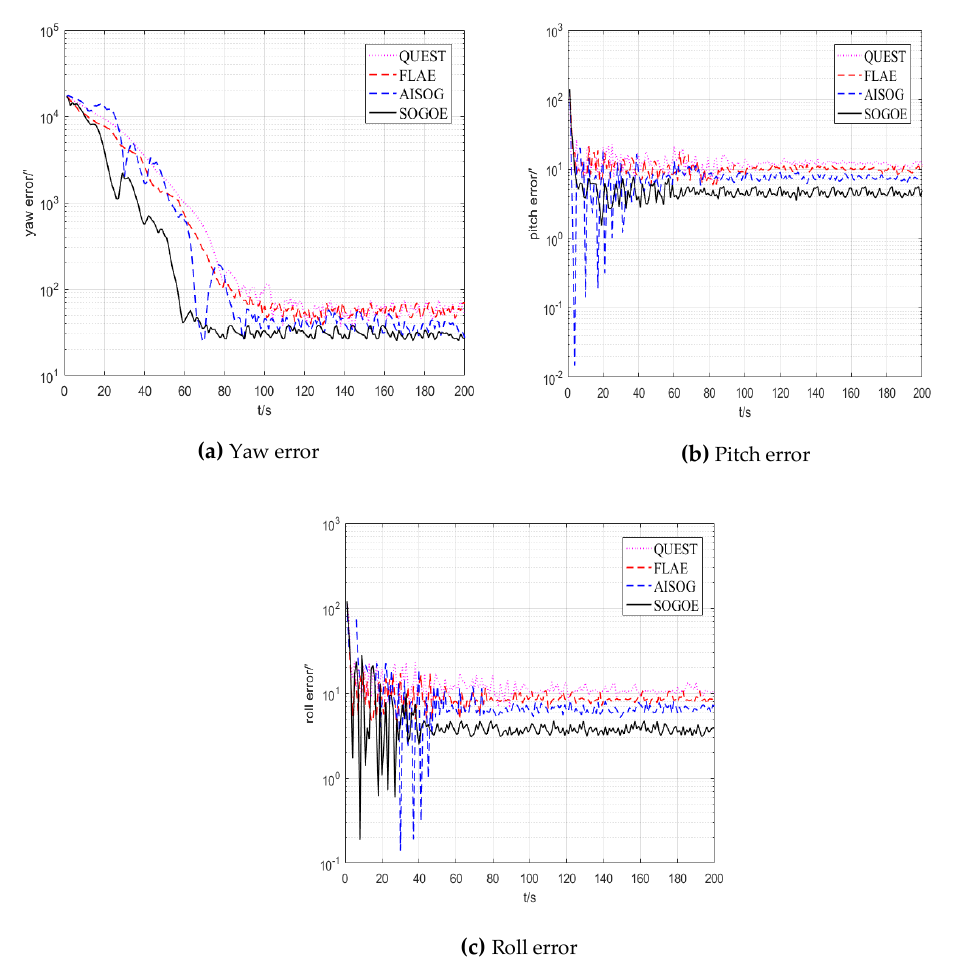
Figure 7. The attitude angle errors of the three alignment methods.